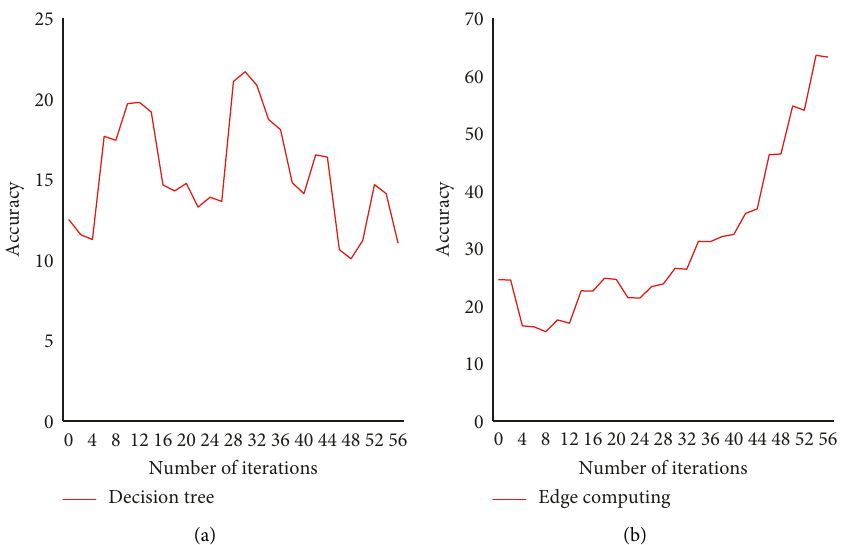
Figure 10: Classification accuracy of edge computing-based three-tier processing architecture and decision tree. (a) Classification accuracy of decision tree. (b) Classification accuracy of three-tier processing architecture based on edge